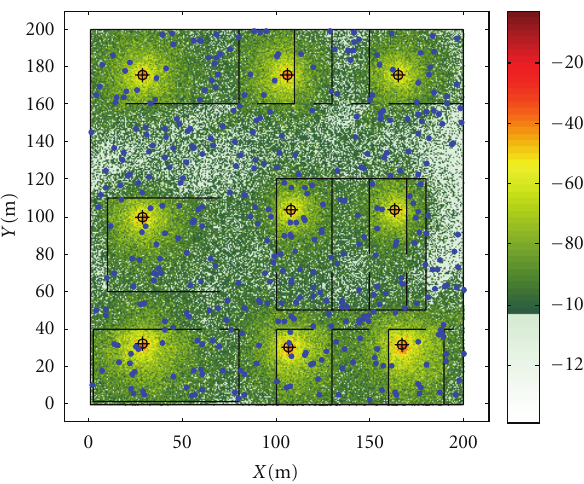
Figure 7: Optimized femtocells coverage when highest weight is given to balance the load, colorbar shows received pilot powers in dBm.